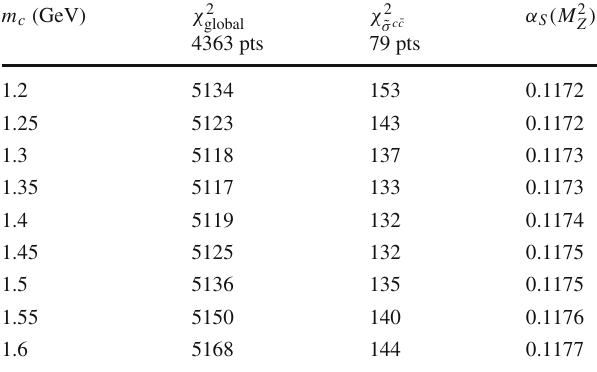
Fig. 16 The quality of the fit versus the quark mass m c at NNLO with α S ( M 2 production ˜ σ c ¯ c ( b (cid:7) ) for the combined H1 and ZEUS data and (right) the full global fit Table 6 The quality of the fit versus the quark mass m c at NNLO with α ( M 2 ) left S Z